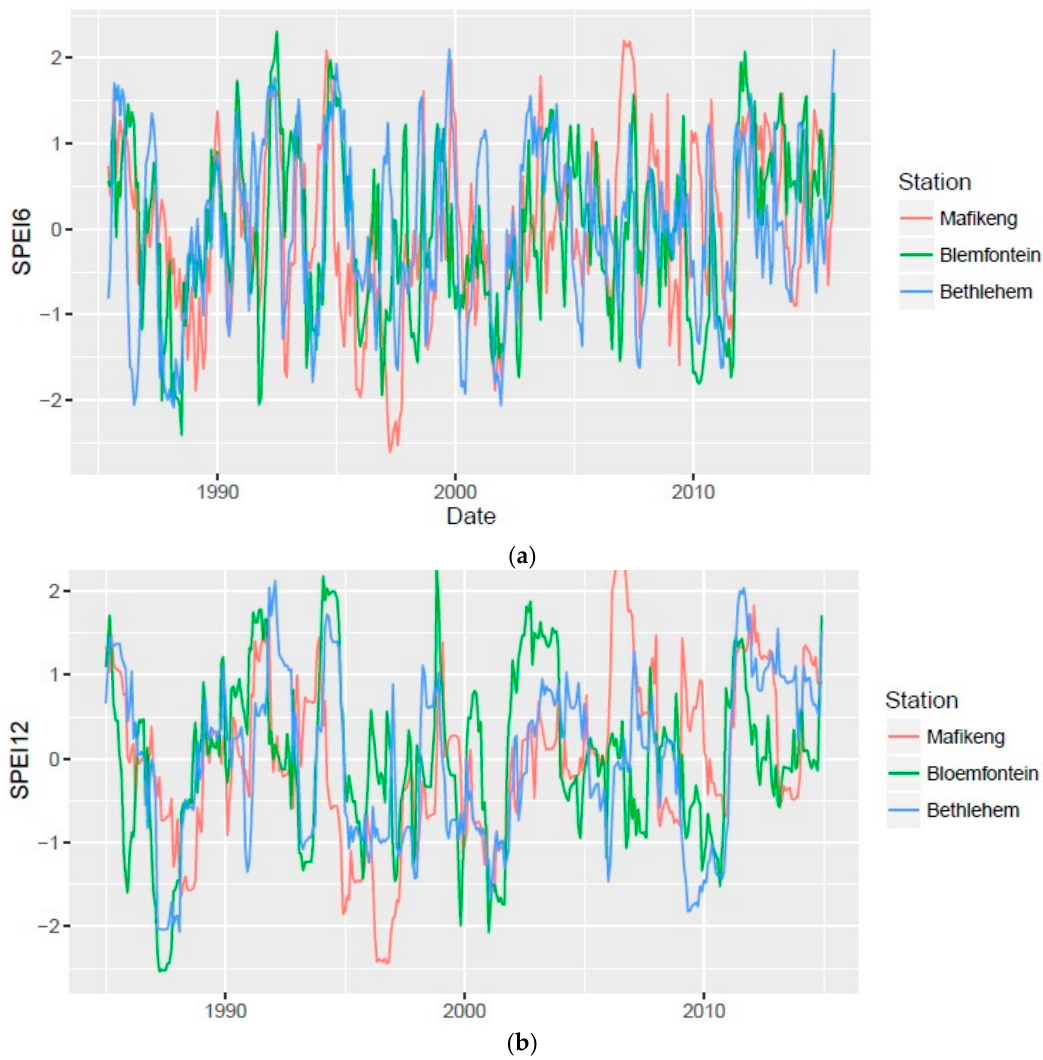
Figure 2. SPEI ‐ 6 ( a ); and SPEI ‐ 12 ( b ) time series from three weather stations. Figure 2. SPEI-6 ( a ); and SPEI-12 ( b ) time series from three weather